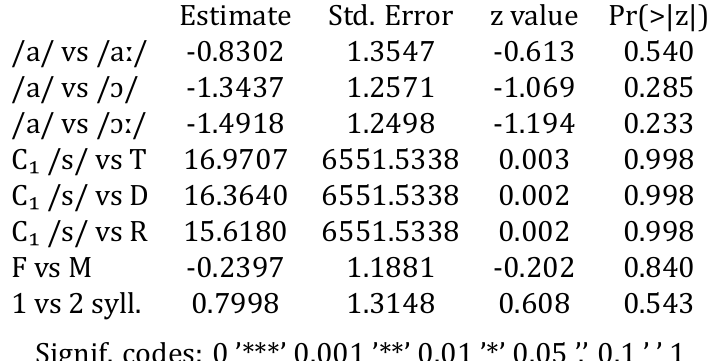
Table A.16: Breathiness duration (ms) prior to C₂ /s/ as a dependent variable